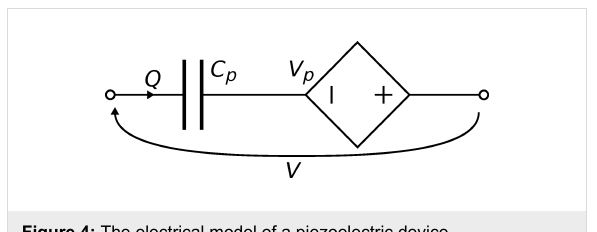
Figure 4: The electrical model of a piezoelectric